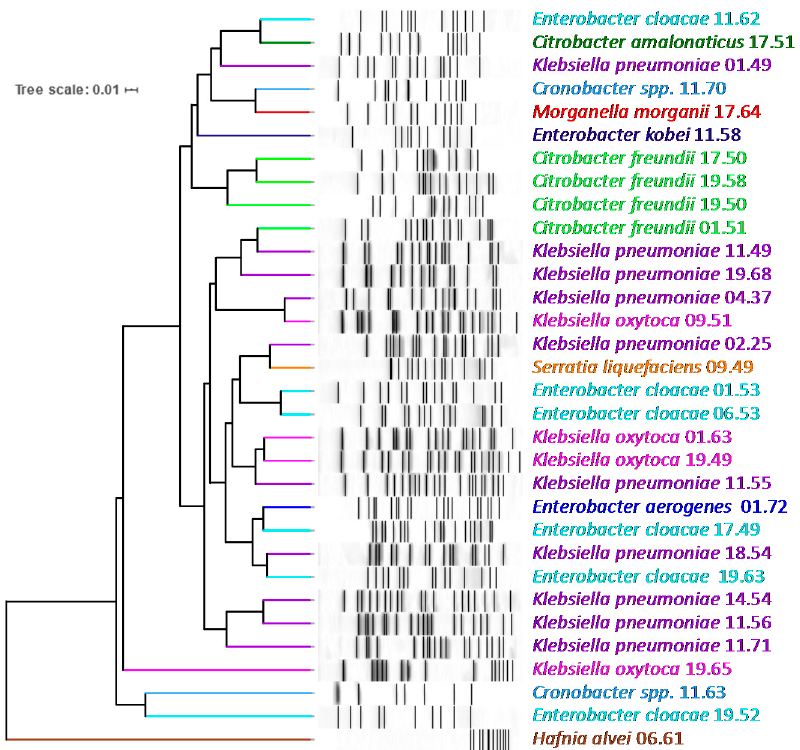
Figure 2. Xba I-PFGE pattern of NECE strains: unweighted pair group method with arithmetic means (UPGMA) dendrogram derived from Dice’s coe ffi cients, calculated based on the band profile. Strains are colored based on their MALDI-TOF MS taxonomic attribution.